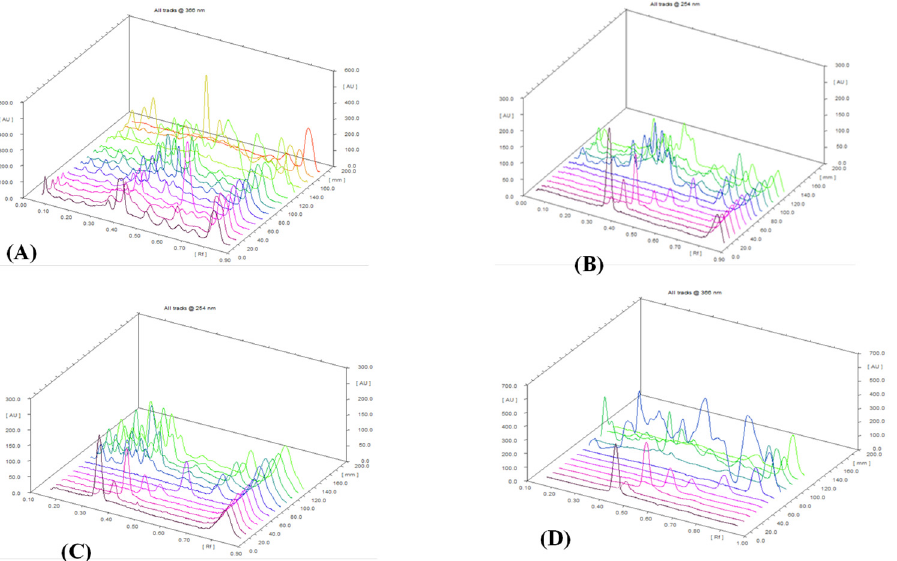
Figure 4. The quantifiable comparison of 3D graphs of the HPTLC fingerprint of 15 Ganoderma species and CRS. ( A ) 15 samples of Ganoderma species (G1–G15). ( B ) G1–G5 and 7 CRS: lucidenic acid N ( 1 ), ganodermanontriol ( 2 ), lucidenic acid E2 ( 3 ), ganoderiol F ( 4 ), lucidadiol ( 5 ), ganodermadiol ( 6 ), and ergosterol ( 7 ). ( C ) G6–G10 and 7 CRS. ( D ) G11–G15 and 7 CRS.